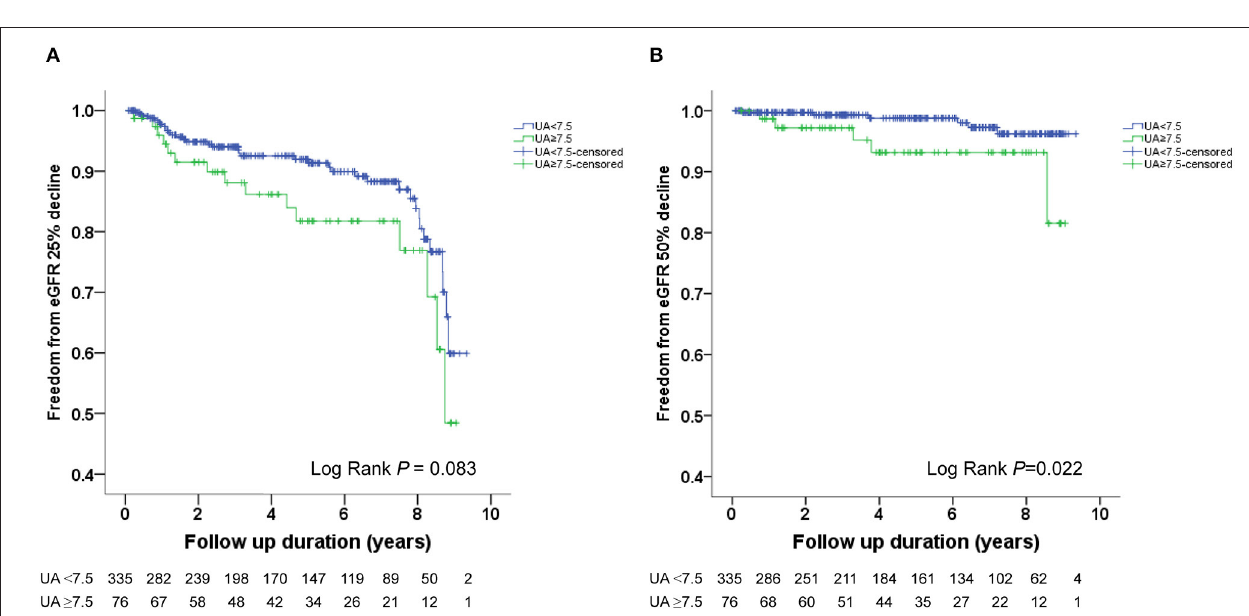
FIGURE 2 | Kaplan-Meier survival curves showing the absence of renal events according to the baseline uric acid (UA) in patients with hypertension. All participants were divided into two groups according to UA levels. The blue line represents the patient group with UA < 7.5 mg/dL. The green line represents the group with UA ≥ 7.5 mg/dL. Renal events were defined as > 25% decline and > 50% decline in eGFR. Differences were compared using the log-rank test. (A) UA ( < 7.5 vs. ≥ 7.5 mg/dL) and > 25% decline in eGFR ( P = 0.083). (B) UA ( < 7.5 vs. ≥ 7.5 mg/dL) and > 50% decline in eGFR ( P = 0.022).